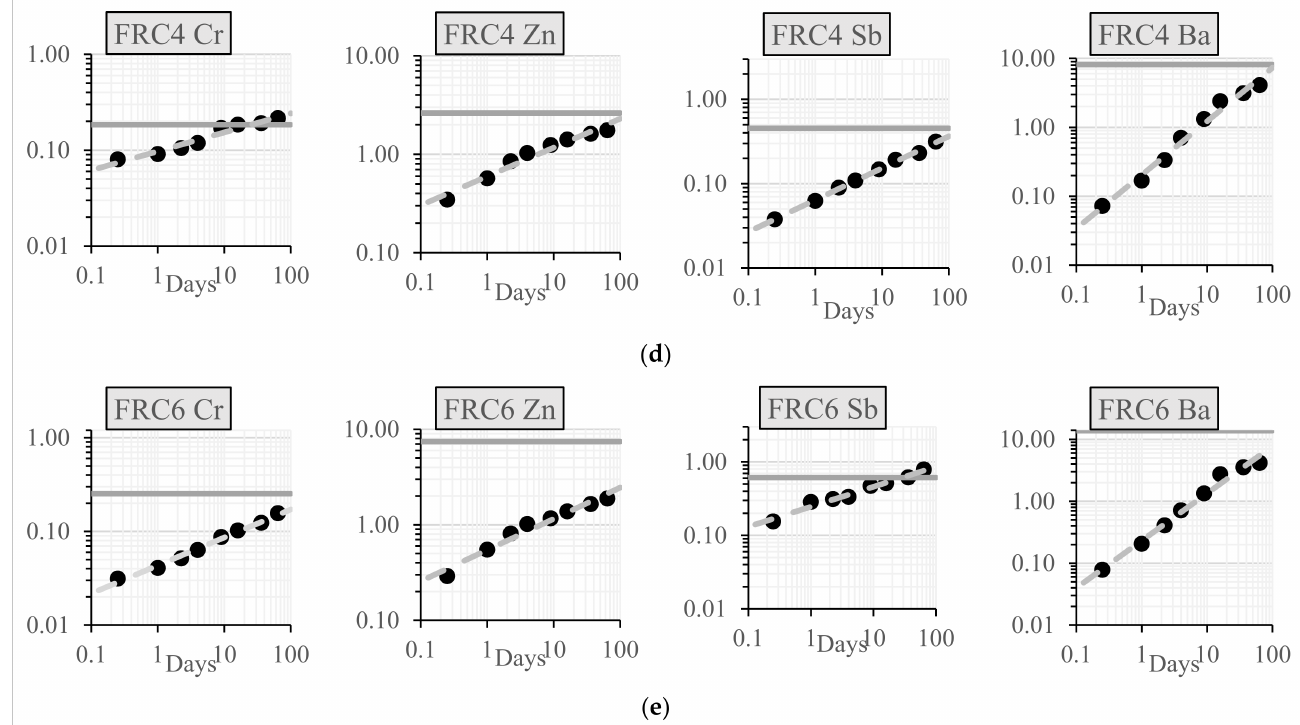
Figure 5. Graphical representation of diffusion-controlled leaching (mg/m 2 ) vs. time (days) in samples: ( a ) control C-REF;